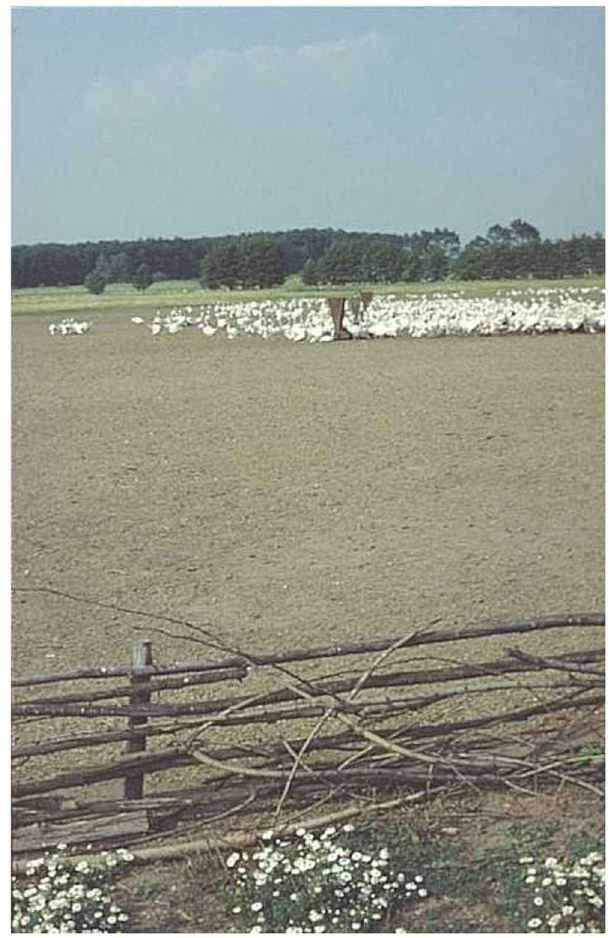
Figure 1. A typical goose farm in 1989 established in a former sand grassland stand in the study area. (photo by G.